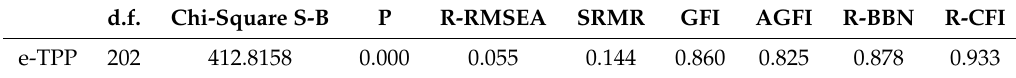
Table 4. e-TPP Model.